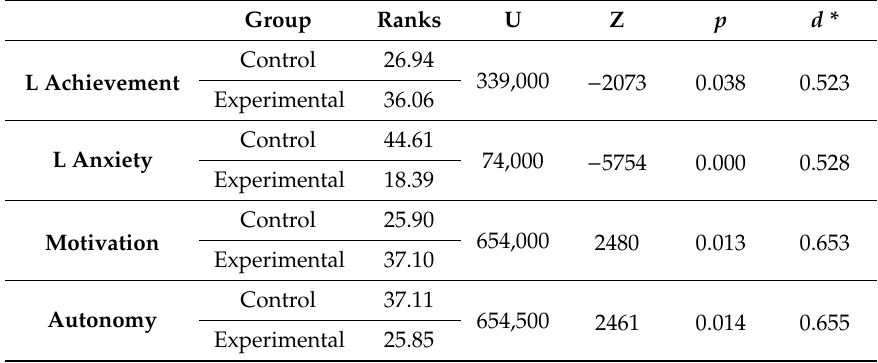
Table 2. Mann–Whitney U test for control and experimental groups differences.